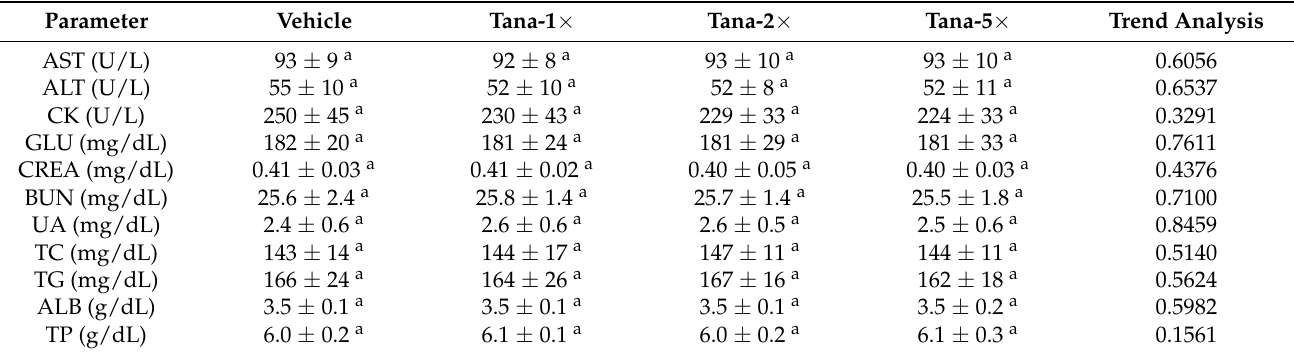
Table 3. Effect of Tana supplementation on biochemical